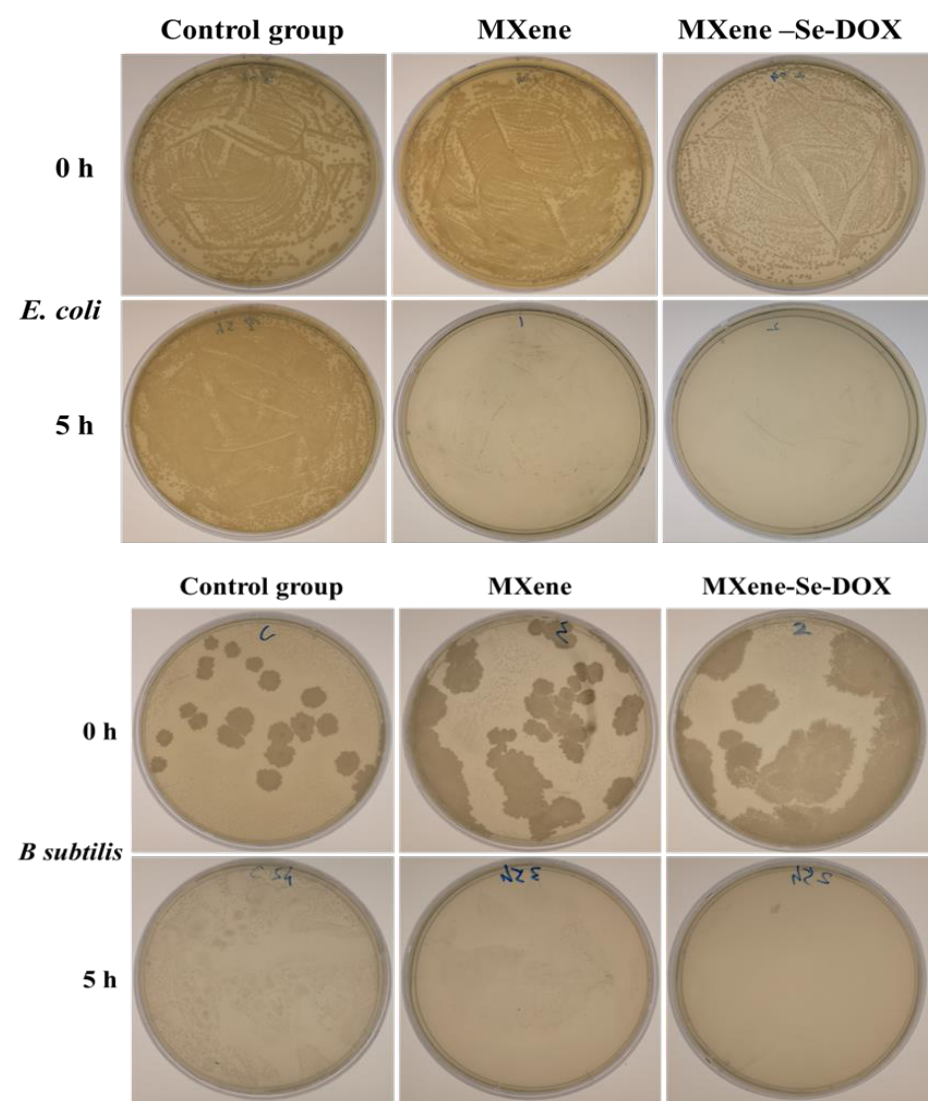
Figure 6. Antibacterial activities in an aqueous solution after 5 h treatment: bacterial suspensions in PBS 7.2 solution (0.01 mM) acted as control. The MXenen and MXene-Se-DOX nanosheets with a concentration of 6.085 mg/mL were recultivated onto E. coli and B. subtilis bacteria, as shown in the photographs of agar plates. All sample analyses were performed in